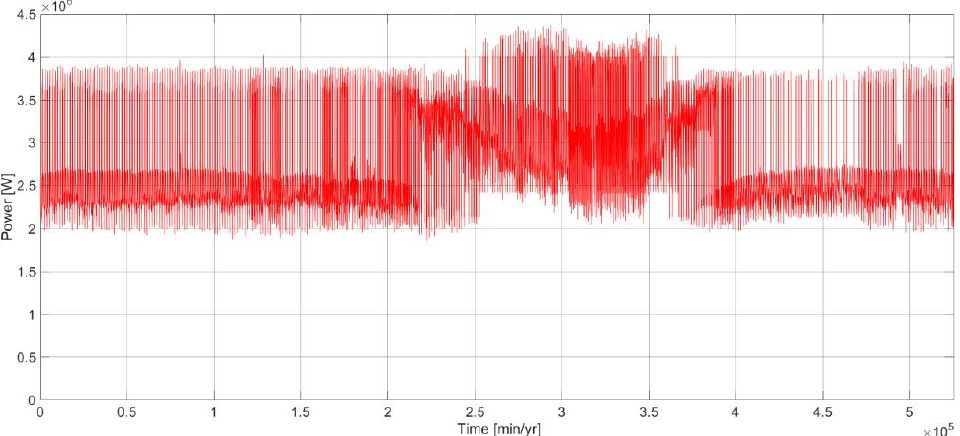
Figure 17. Example of spinning reserve of the system (BESS + generators).